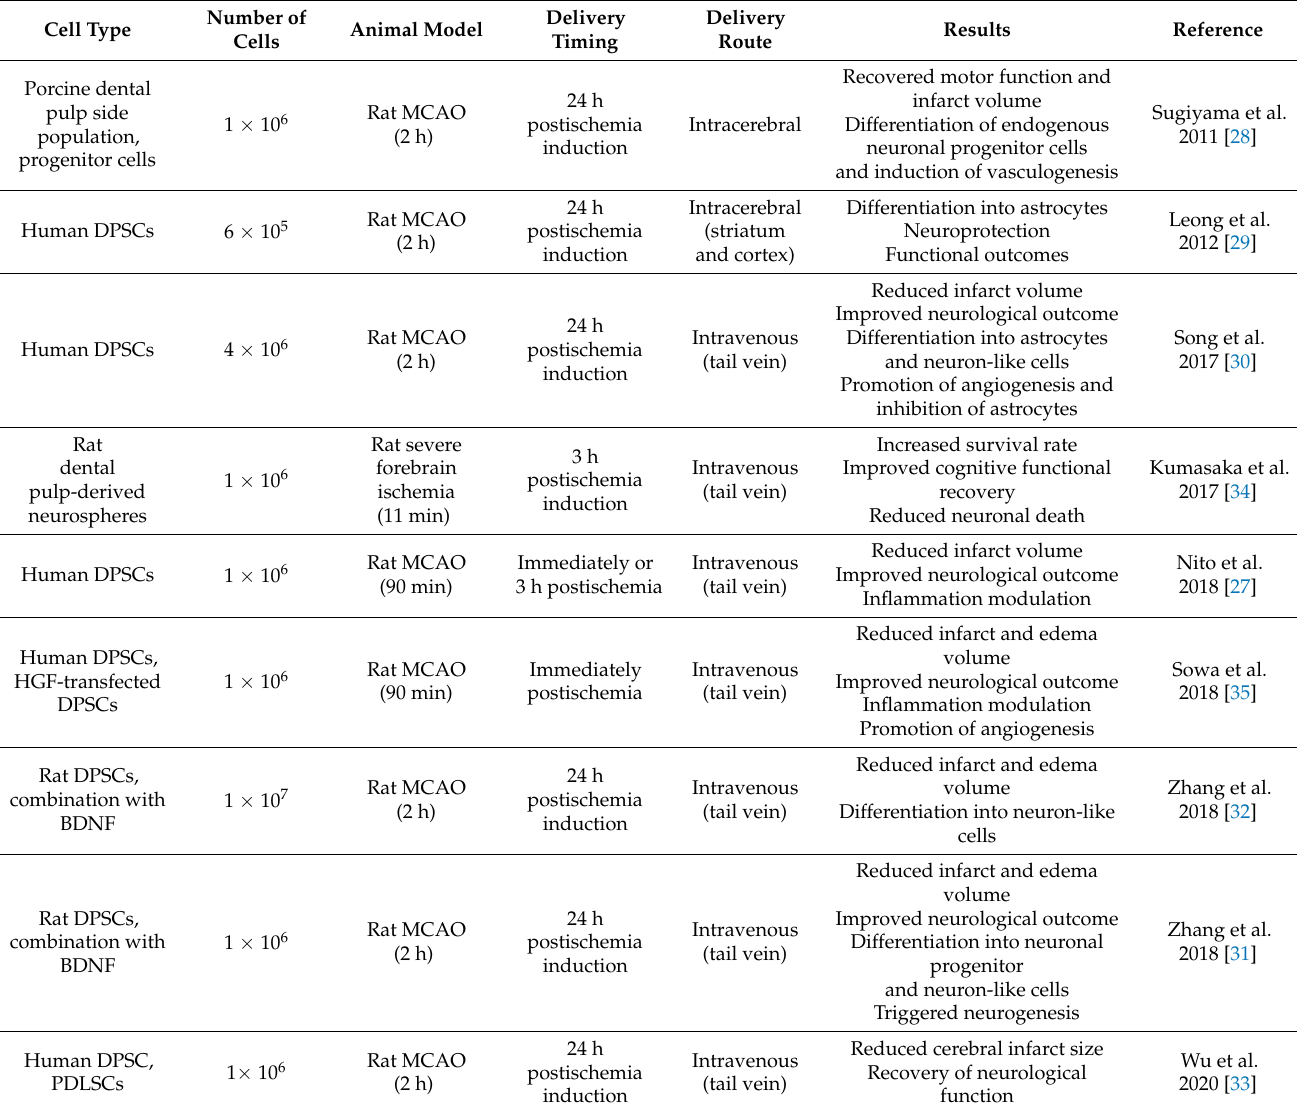
Table 1. Experimental studies using dental pulp stem cells (DPSC) for the treatment of ischemic brain injury in animal